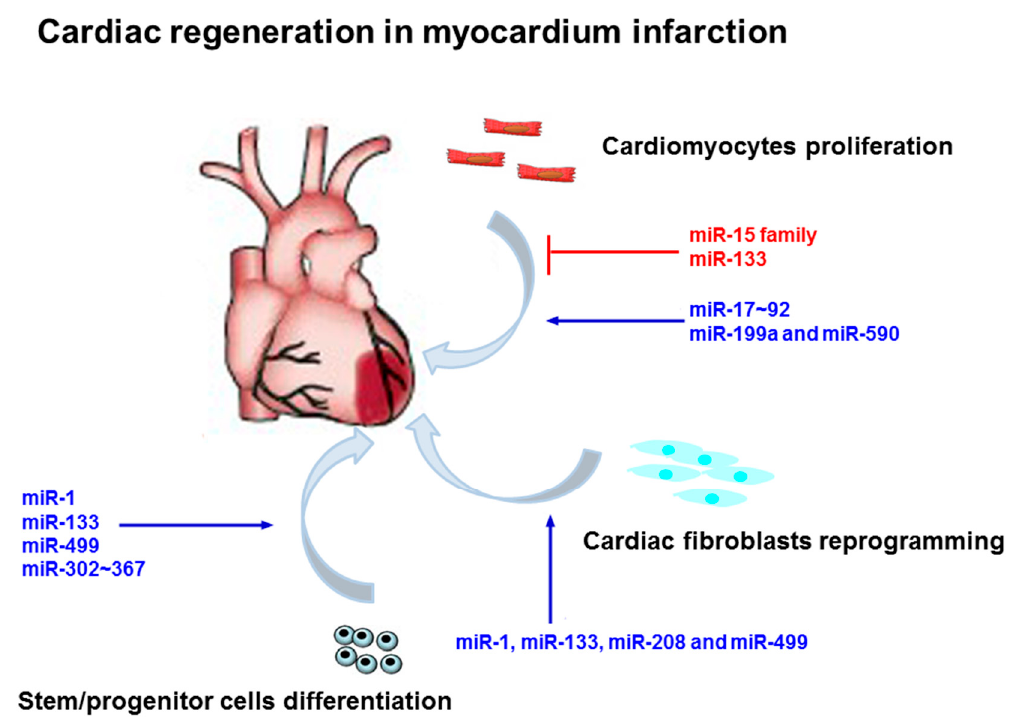
Figure 3. Summary of miRNAs functioning to regulate cardiac regeneration in MI. Cardiomyocytes proliferation, cardiac fibroblasts reprogramming and stem/progenitor cells differentiation mediated by miRNAs are shown in the figure. See text for detailed explanations. Both blue and grey arrows represent the promotion effect. T bars represent the inhibition effect.